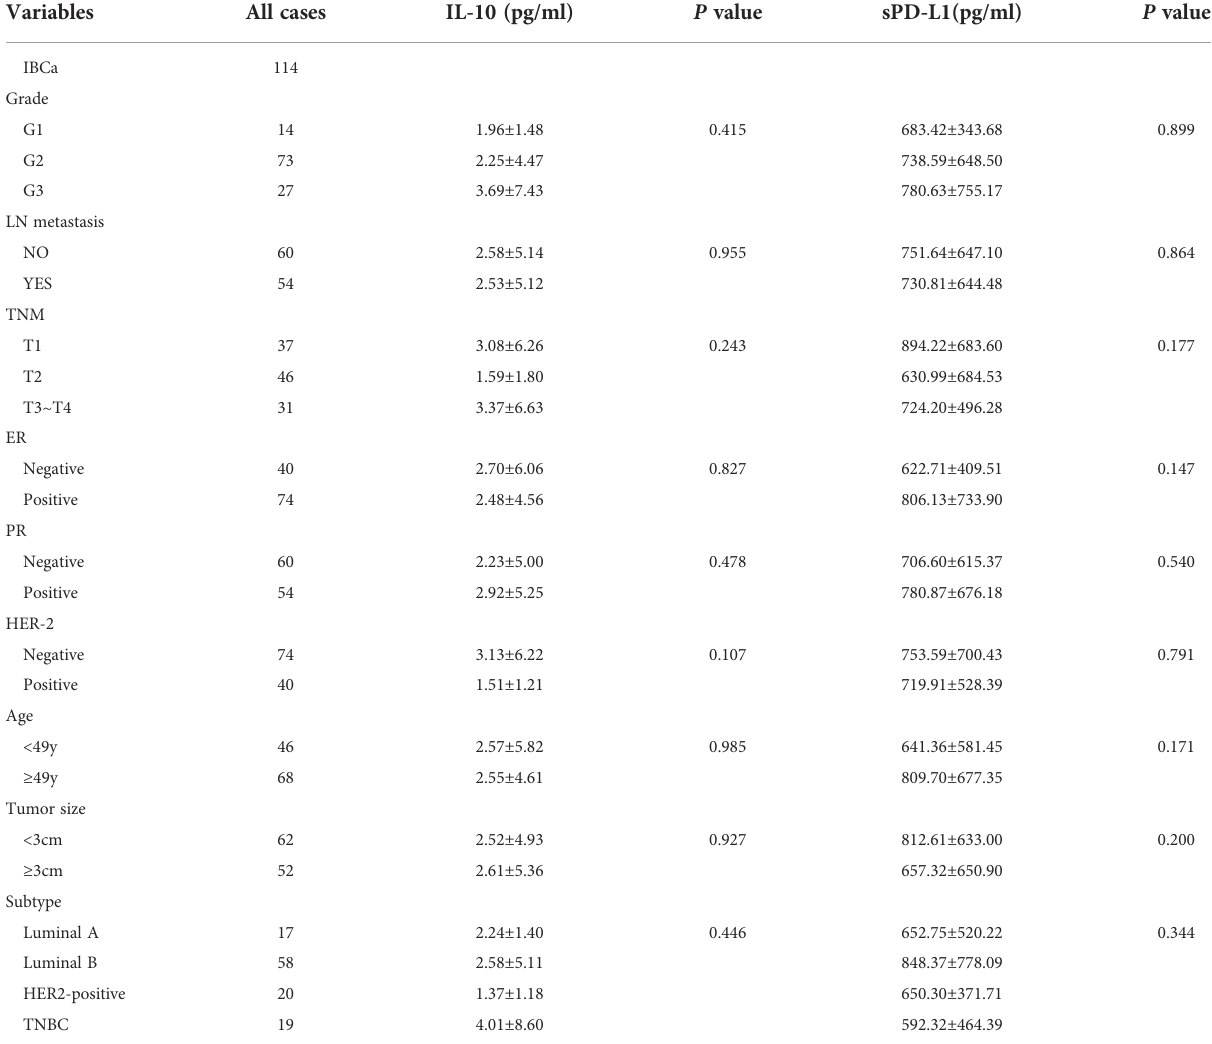
TABLE 5 Relationship between the level of IL-10 and sPD-L1 in serum and the clinicopathological parameters of IBCa patients.